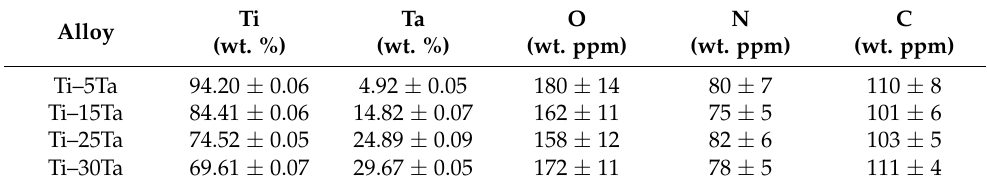
Table 1. Chemical composition of Ti–xTa alloys. Ti Ta O Alloy